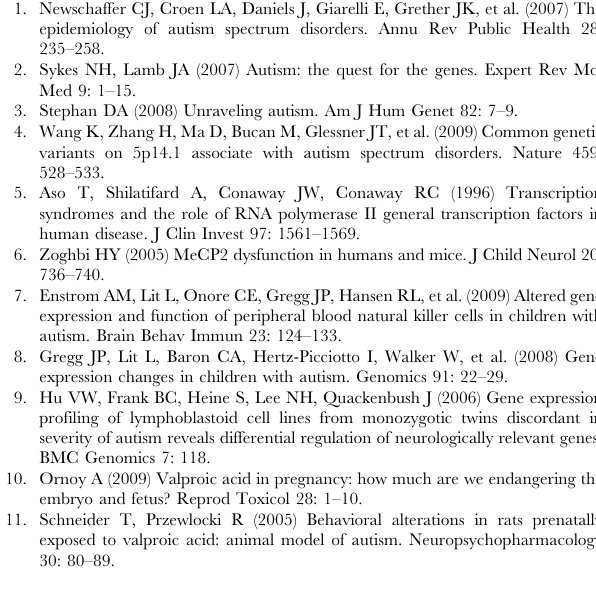
table illustrates that cross-validation datasets highlighted the same enrichment of biological pathways related to transcription and zinc. (PDF) Table S2 Non-overlapping down-regulated genes. Path- way analysis was done on significant gene lists (p , .05, absolute fold change . 1.1) of genes that were down-regulated in autism or in children of older fathers and not overlapping with the other group. Table S3 Up-regulated Pathways. Pathway analysis was done on significant gene lists (p , .05, absolute fold change . 1.1) of genes that were up-regulated in autism or in children of older fathers. (PDF) Table S4 Pathway analysis with increased stringency for gene list selection. Pathway analysis was done on significant gene lists (p , .05, absolute fold change . 1.25, and present calls . 51%) of genes that were down-regulated in autism and in children of older fathers. Table shows that the same pathways were enriched as with lower stringency gene list